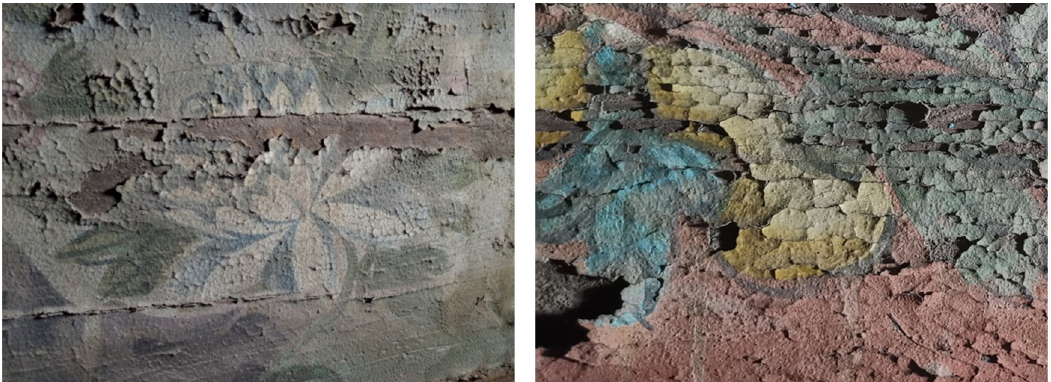
Figure 1. The color painting surface of Sanyou Xuan, the Forbidden City. Due to the synergistic effect of light and salt, the surface of color painting appears powdering, peeling, and warping.